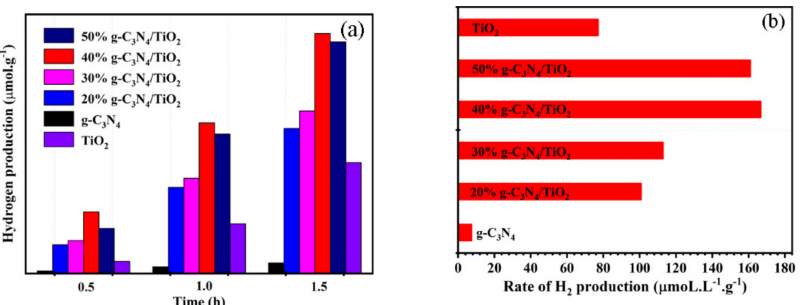
Figure 8. Photocatalytic hydrogen production ability ( a ) and hydrogen production rate tests ( b ) of g-C 3 N 4 , TiO 2 , and g-C 3 N 4 /TiO 2 samples.